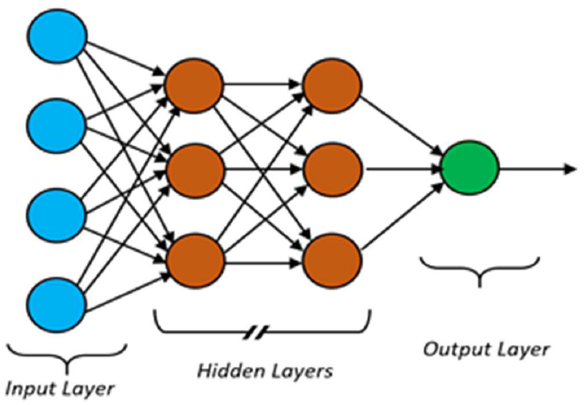
Figure 2. General architecture of the BPNN.